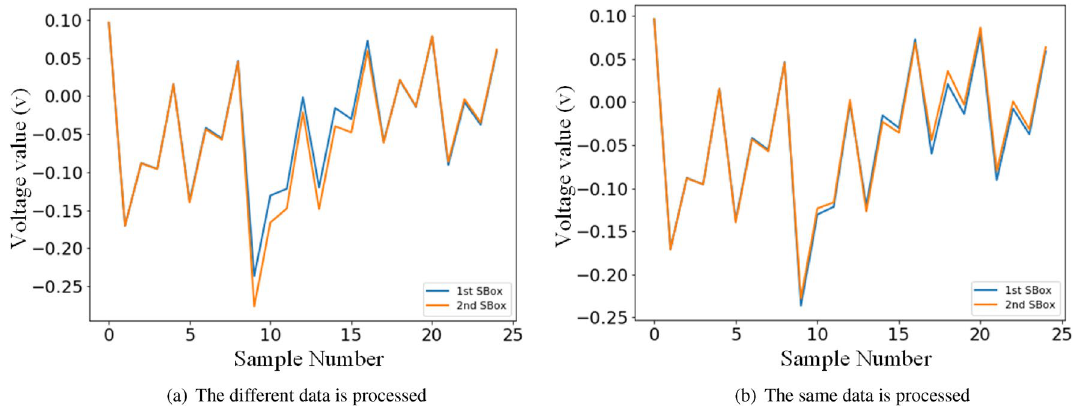
Figure 2. Power traces captured from an 8-bit microcontroller implementation of AES, which represent the first SBox and the second SBox operations in the first round. Traces look very similar if the same data is